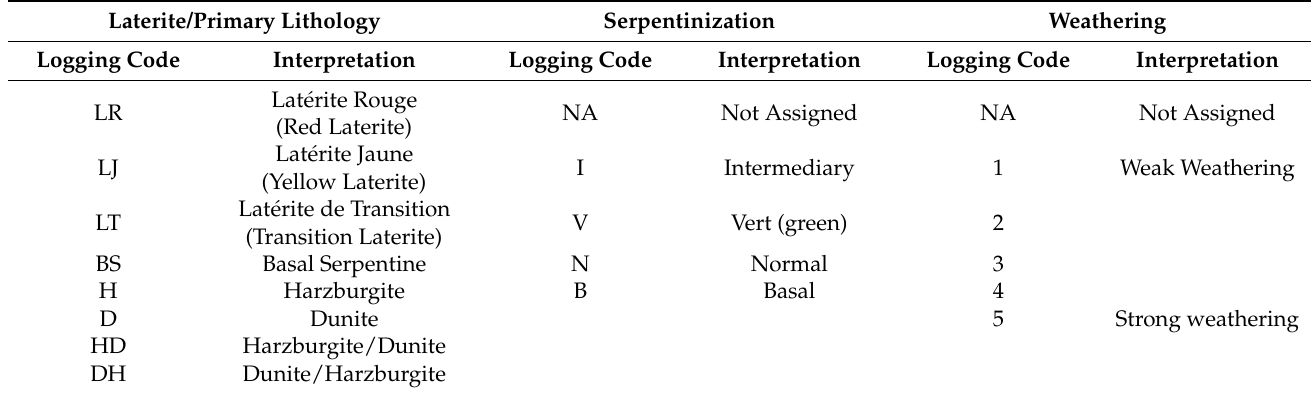
Table 1. Interpretation of geological domaining samples.